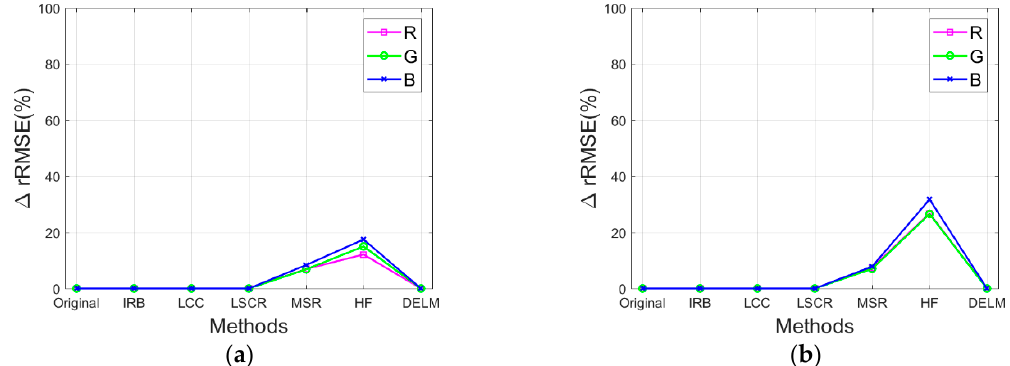
Figure 9. ∆ r RMSE between non-shadow regions in the original image and those in the shadow compensation resulting images by various shadow compensation algorithms for test images in terms of R, G, and B components. ( a ) Tripoli-1. ( b ) Tripoli-2.